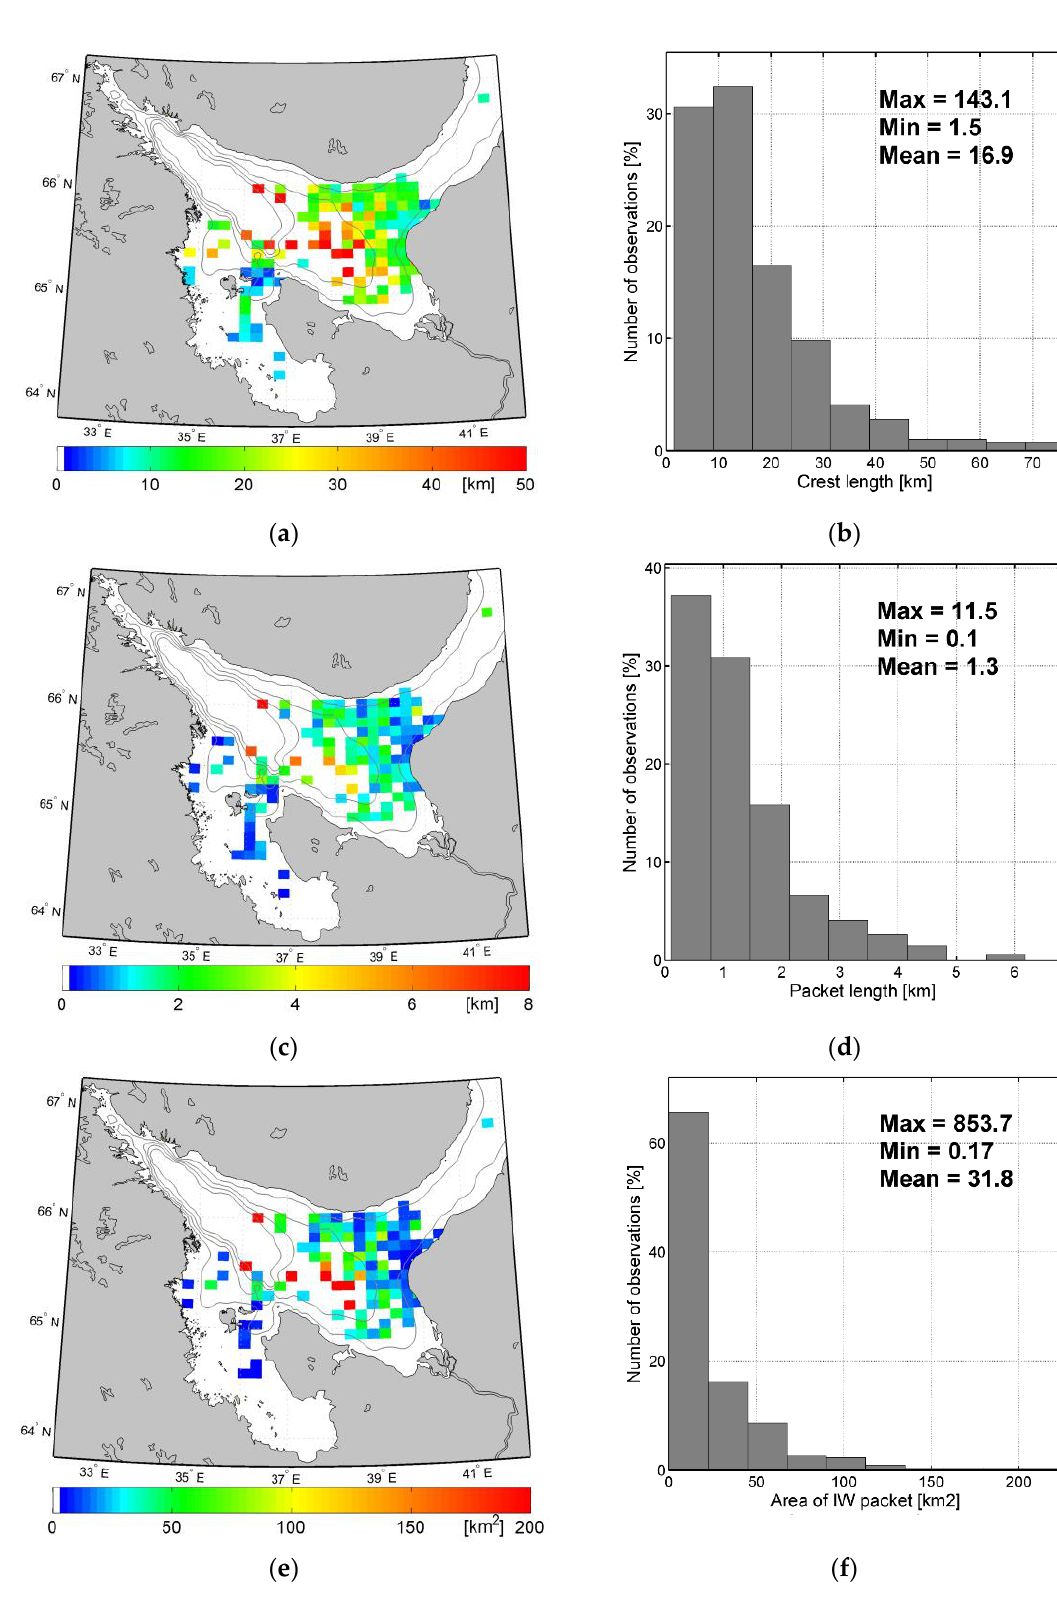
Figure 8. Spatial maps ( a , c , e ) and histograms ( b , d , f ) of ISW crest length, packet length ( c , d ), and area ( e , f ).